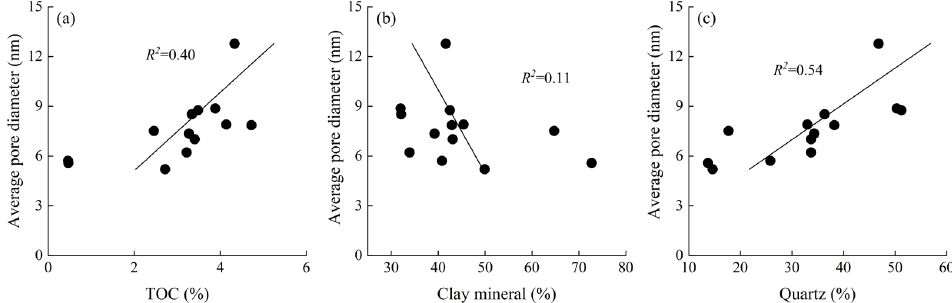
Figure 9. ( a ) Relationship between average pore diameter and TOC; ( b ) Relationship between average pore diameter and clay mineral; ( c ) Relationship between average pore diameter and quartz.